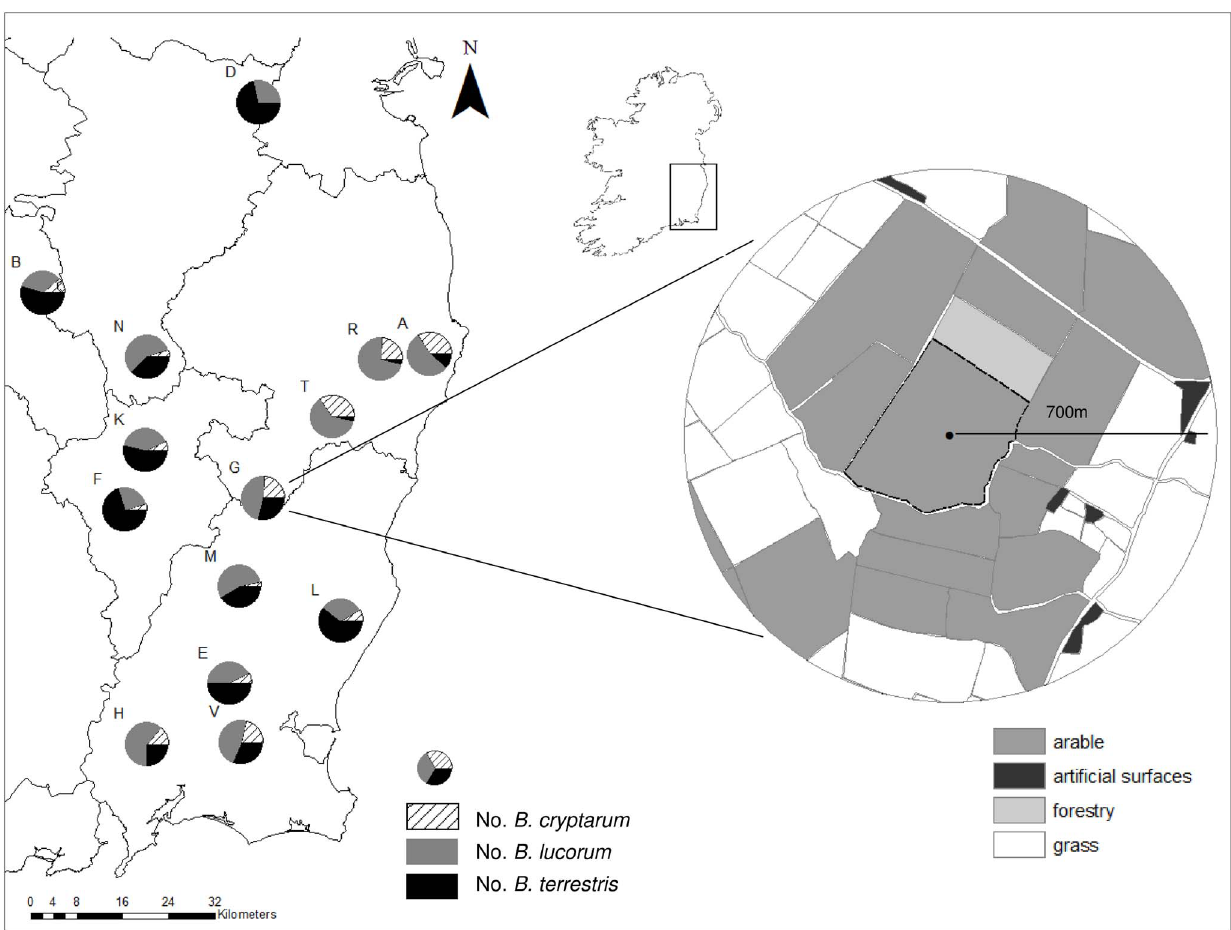
Figure 1. Location of the 14 spring oilseed rape fields in South East Ireland, and proportions of each of the cryptic species identified in each site. An example of the landscape mapped at a 700 m radius around each field is given, with the focal oilseed rape field highlighted with a dotted line.